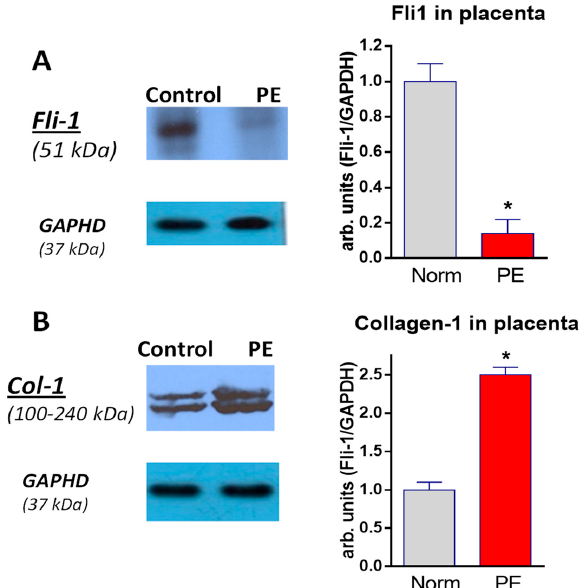
Figure 1. Western blots of Fli-1 ( A ) and collagen-1 ( B ) in placentae from normotensive pregnant subjects (grey columns) and patients with preeclampsia (PE; red columns). Left—representative Western blots, right—bars representing means ± SEM from 4 densitometry measurements. By t -test: * * p < 0.01 vs. normotensive pregnant subjects. Levels of Fli-1 and of collagen-1 were normalized against levels of GAPDH.